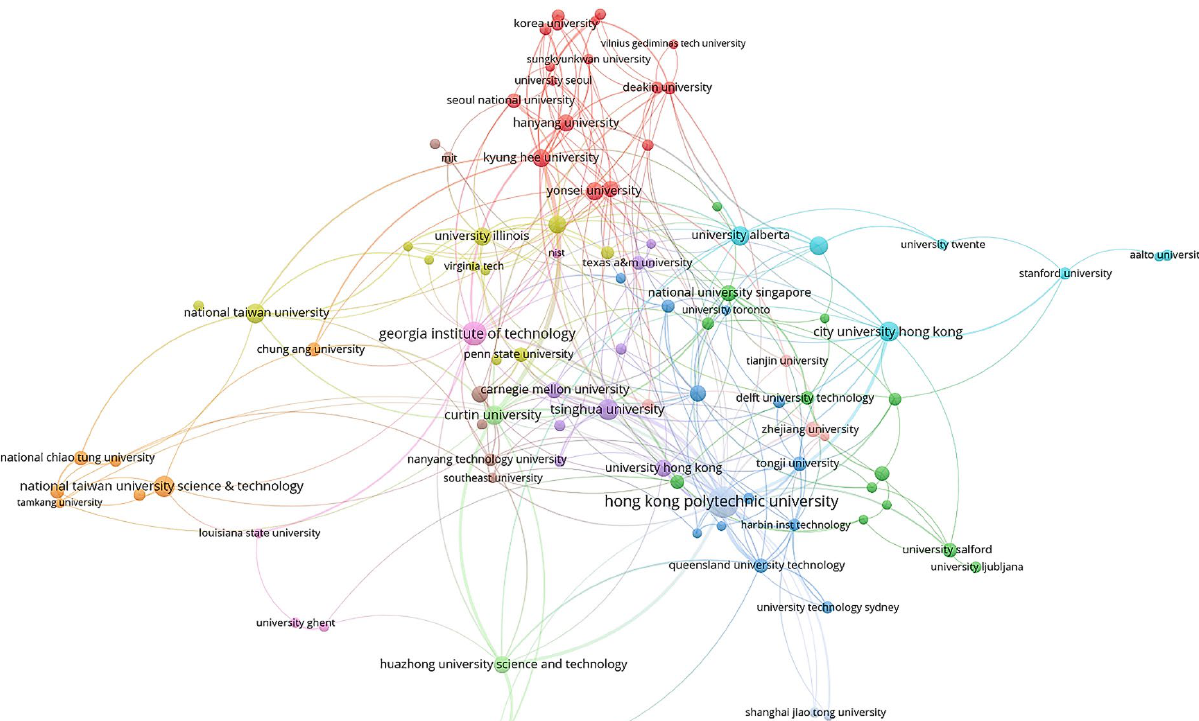
Figure 3. The institute co-authorship